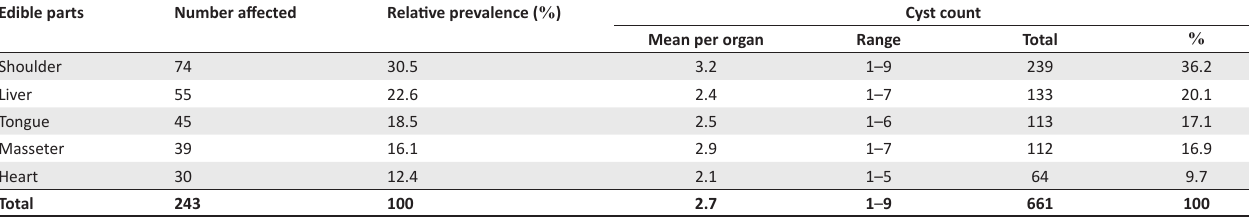
Tongue 45 Masseter